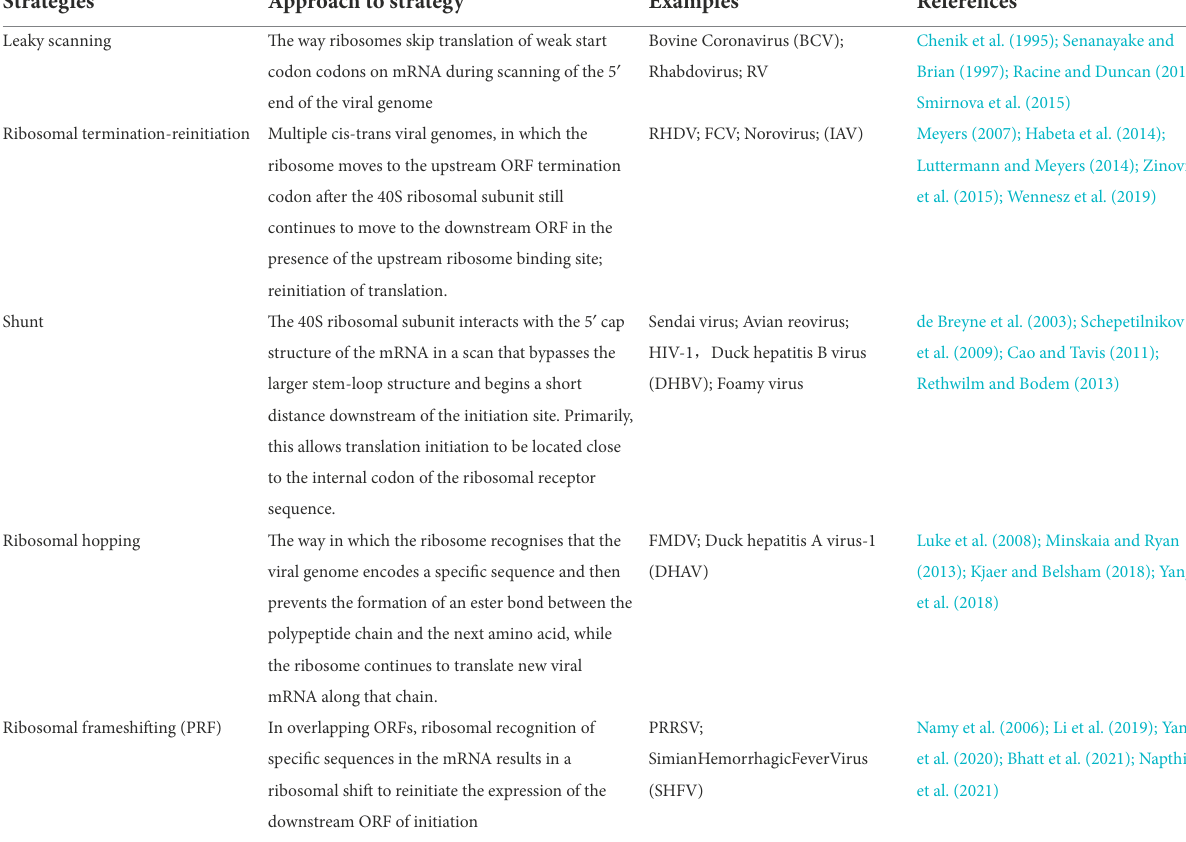
TABLE 2 Different translation initiation strategies of RNA